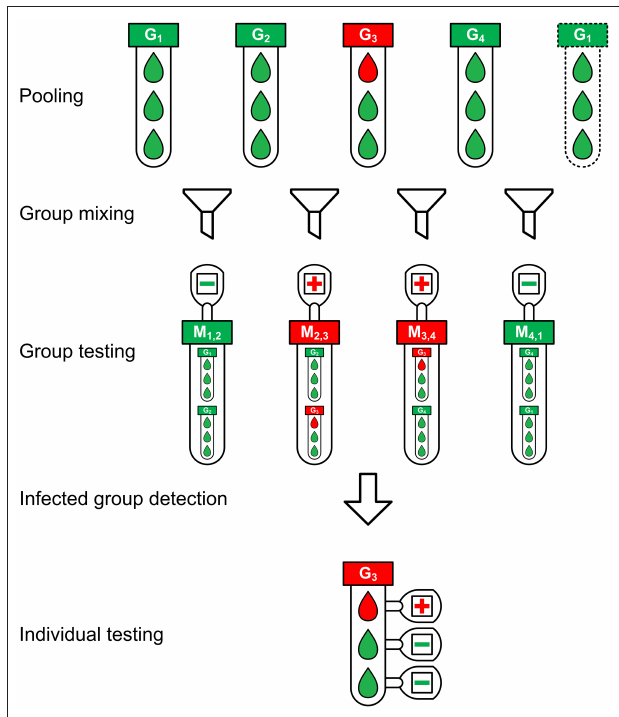
FIGURE 1 | The schematic diagram of the groupMix method for non-conservative infected group detection.